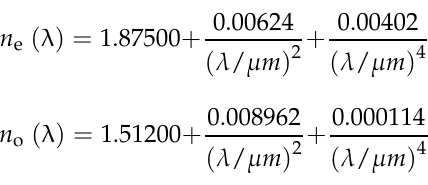
Figure 5. Simulation results for ray distributions for the high- ∆ n LC GRIN lens arrays with ( a ) spherical, ( b ) quadratic polynomial aspherical, and ( c ) high-order polynomial aspherical interfacial curvatures.